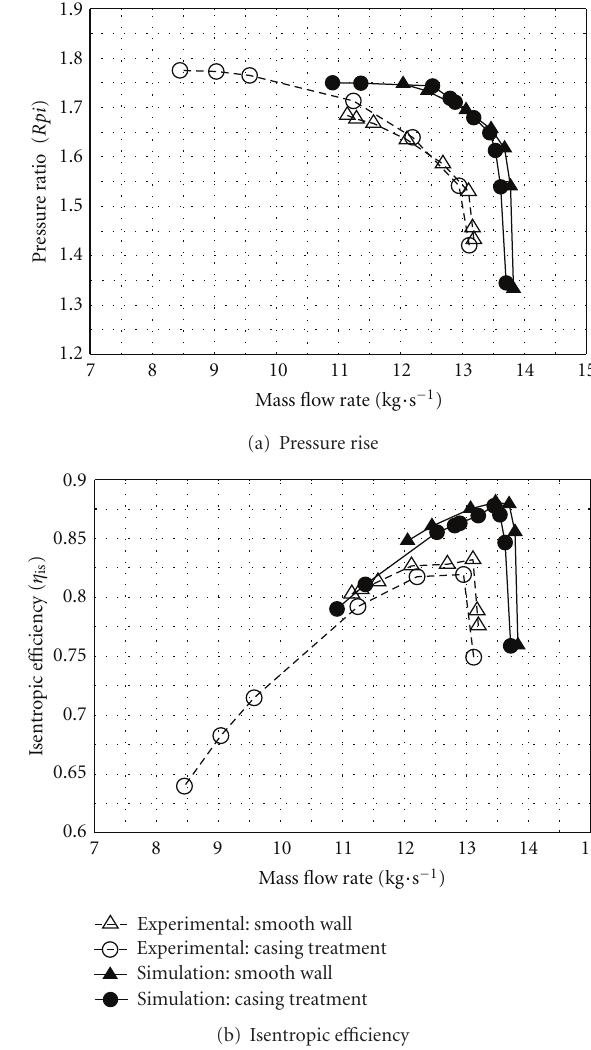
Figure 8: CREATE characteristics relative to nominal operating point (experimental versus numerical simulations).